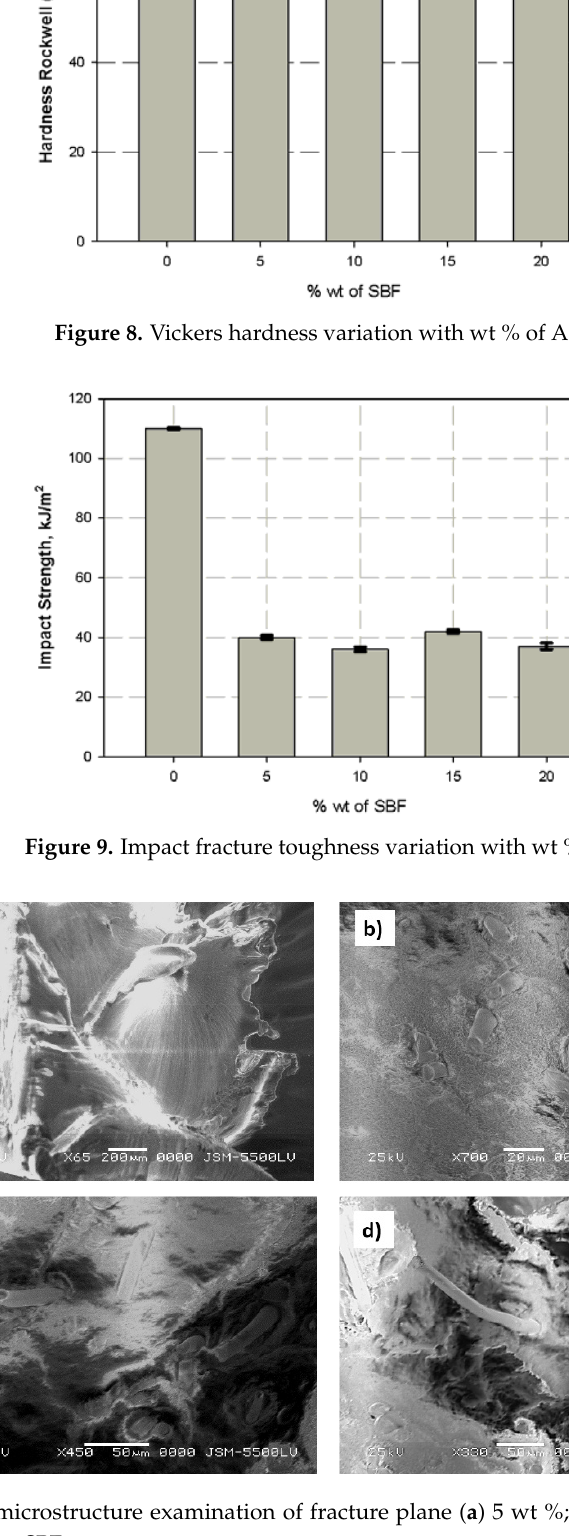
Figure 10. SEM microstructure examination of fracture plane ( a ) 5 wt %; ( b ) 10 wt %; ( c ) 15 wt %; ( d ) 20 wt % content SBF.